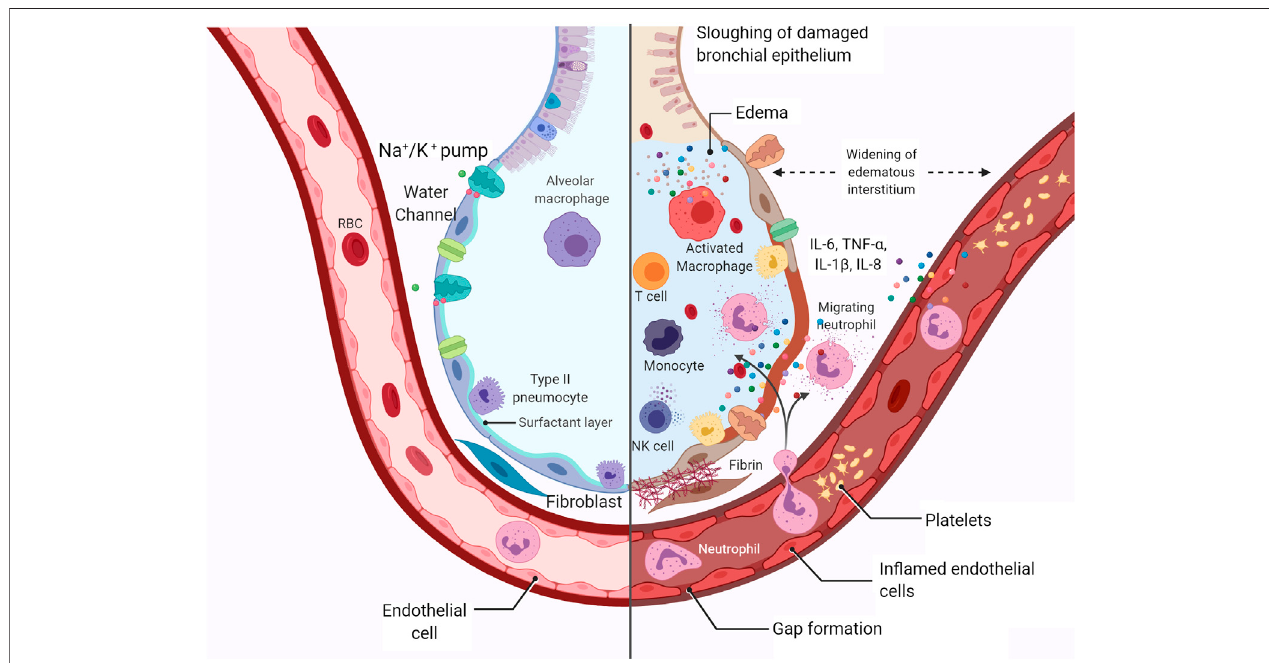
FIGURE 2 | Representation of healthy alveoli and SARS-CoV-2-injured alveoli. Representation of alveolar damage during COVID-19 infection, with interstitial and alveolar edema, cytokine activation, neutrophil migration, Na + /K + -ATPase, water channel assisting the edema removal, diapedesis, recruitment of T cells and NK cells, epithelial cell death, and initial fi brin deposition. Created with